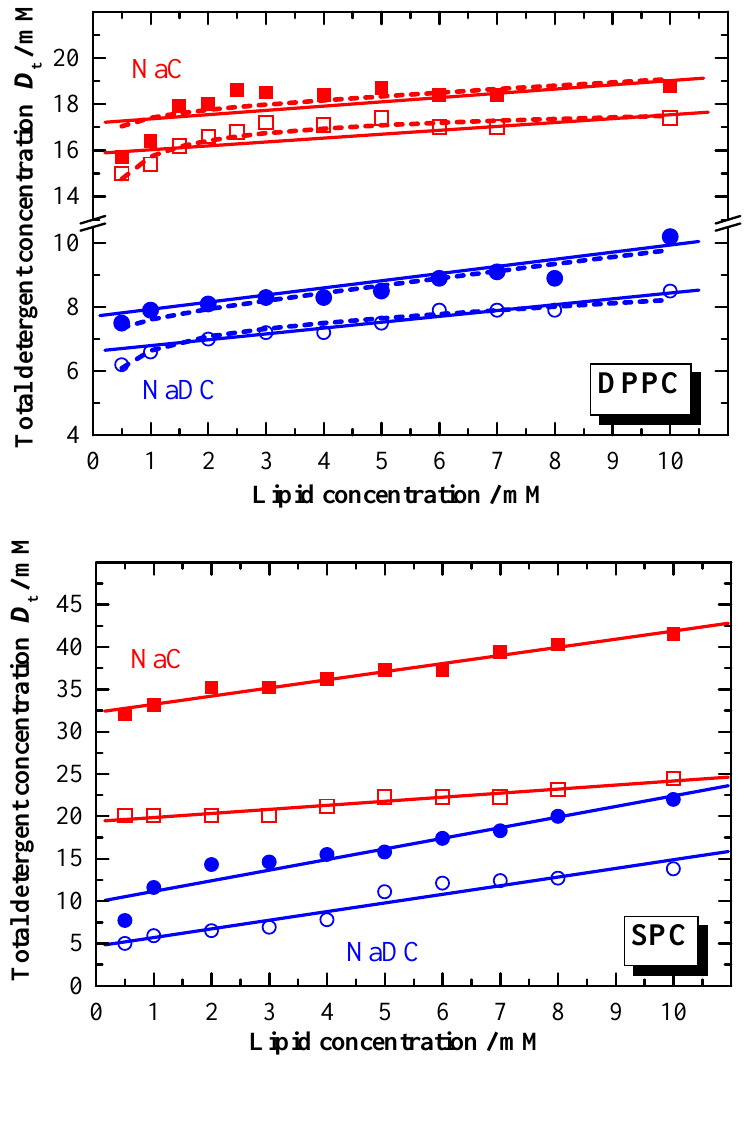
Figure 7. Phase diagrams for the vesicle-to-micelle transition (membrane solubilisation) in NaC/DPPC, NaDC/DPPC, NaC/SPC and NaDC/SPC in water ( pH 7.5) at T = 60 ° C. Phase boundaries are represented by the experimentally obtained data D tsat (open symbols) and D tsol (closed symbols). Solid lines: phase boundaries calculated according to equation 13, dashed lines: phase boundaries calculated according Roth et al .